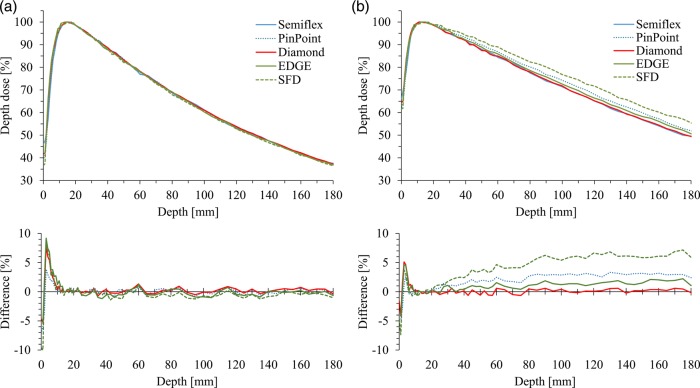
Percentage depth–dose of a 6-MV photon beam of (a) 3 × 3 cm2 and (b) 30 × 30 cm2 field sizes. For each data, the difference from Semiflex chamber is plotted in the lower graphs. Note that the diamond data has the smallest difference at depths and field size.